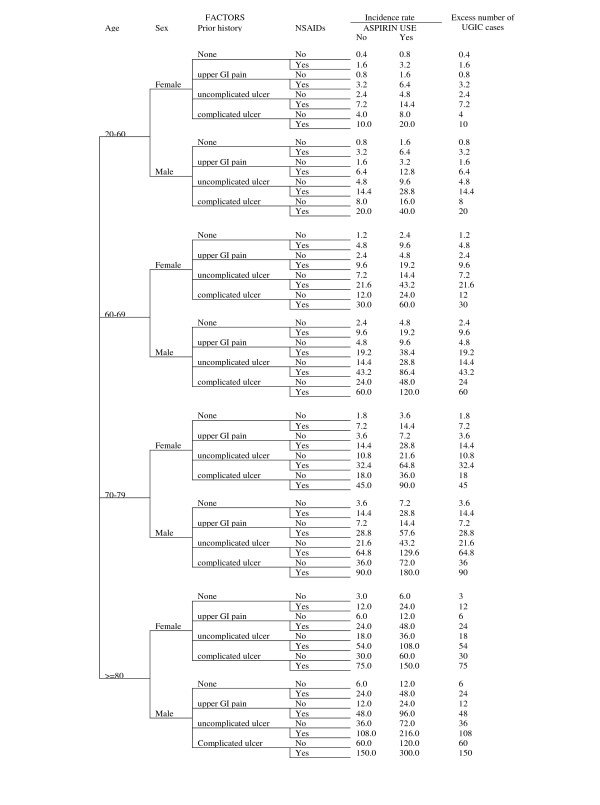
Estimated incidence rate of upper gastrointestinal tract complications (UGIC) per 1,000 person-years and estimated excess number of cases per 1,000 cardioprotection aspirin users per year attributable to aspirin within levels of gastrointestinal risk factors.